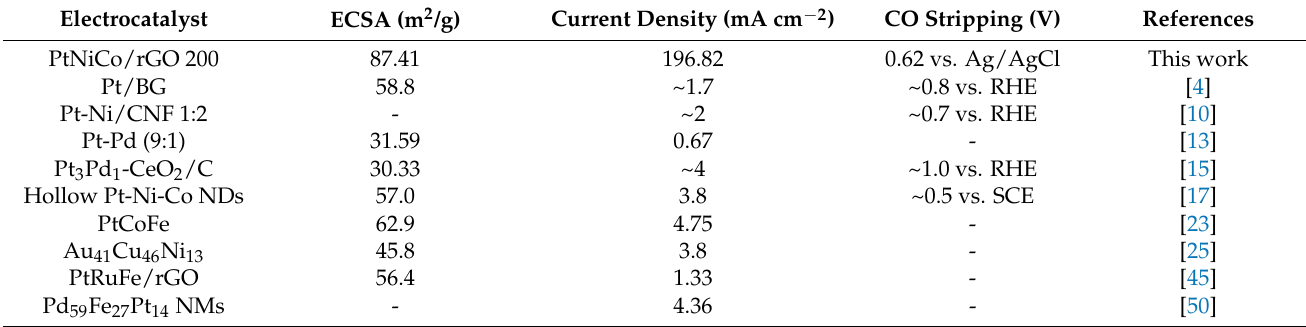
Table 1. ECSA and current density of methanol oxidation of various electrocatalysts in previous works. Electrocatalyst